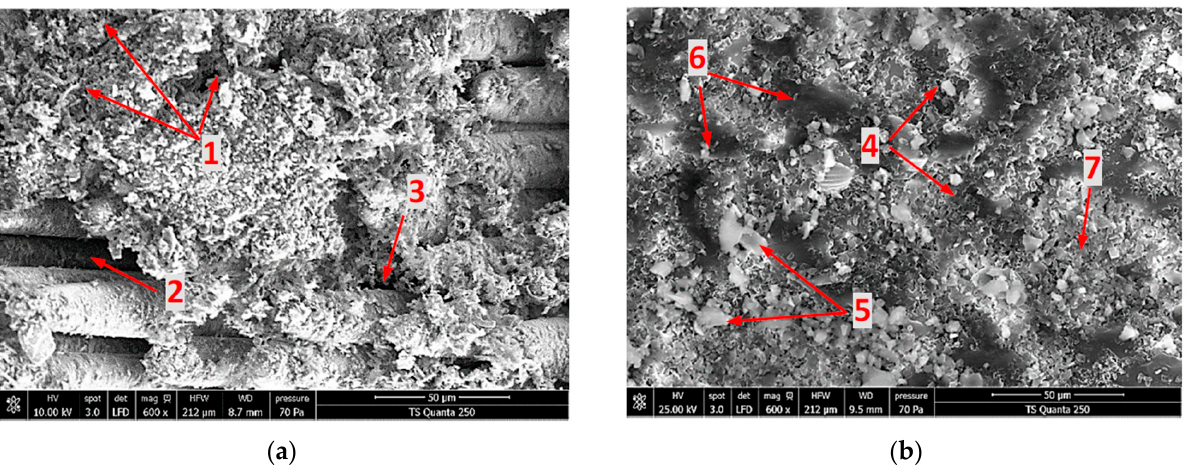
Figure 10. SEM Micrographs obtained when edge trimming of TCP composites perpendicular to fiber orientation. Legend : ( 1 ) Matrix cracking, ( 2 ) Interface failure, ( 3 ) Matrix loss, ( 4 ) Cut-section of GF, ( 5 ) Milled silica grains, ( 6 ) Digged area, ( 7 ) Matrix debris. ( a ) Specimen C. ( b ) Specimen E.